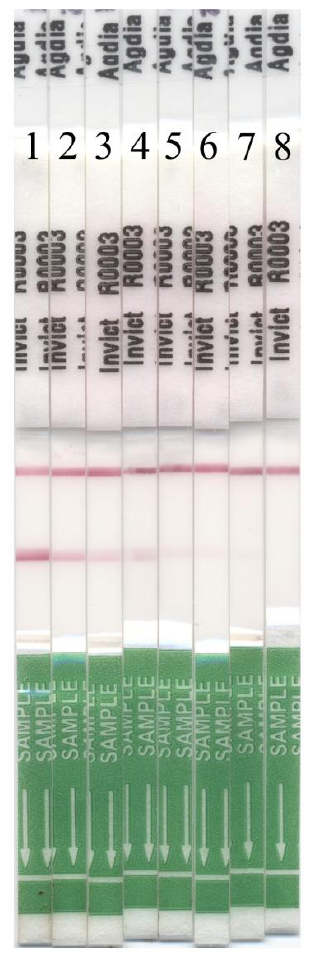
Figure 4. Range of responses from InvictDetect TM Immunostrips ® interrogated with a single worker ant. Samples 1–7 are positive responses. Sample 8 is a negative control.